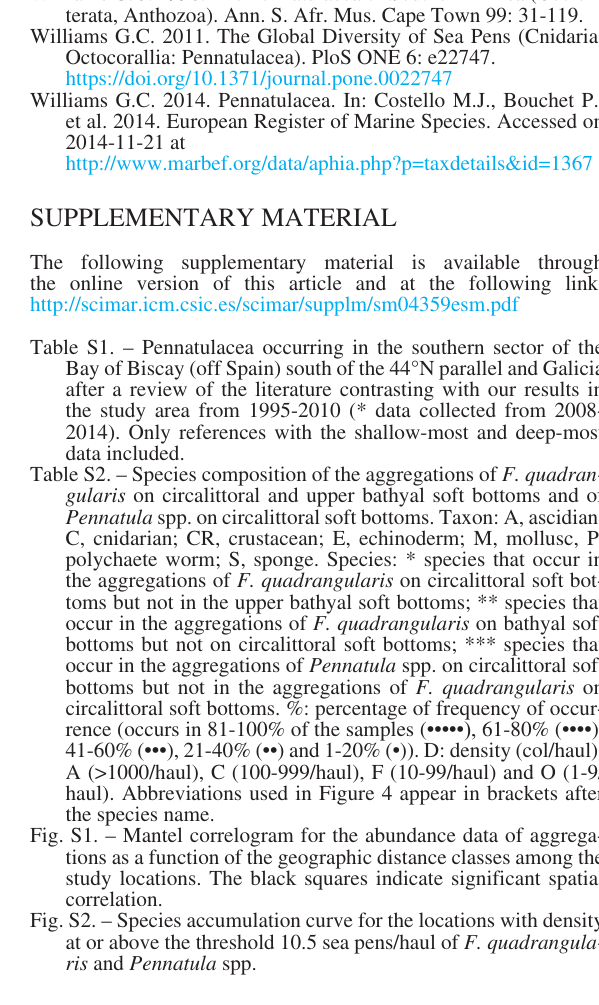
the species name. Fig. S1. – Mantel correlogram for the abundance data of aggrega- tions as a function of the geographic distance classes among the study locations. The black squares indicate significant spatial correlation. Fig. S2. – Species accumulation curve for the locations with density at or above the threshold 10.5 sea pens/haul of F. quadrangula- ris and Pennatula